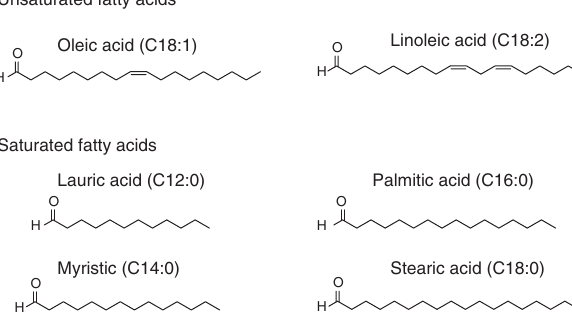
Figure 9 Examples of fatty acids that have been examined by HPAC for their effects on the binding of sulfonylurea drugs with normal HSA or glycated HSA.